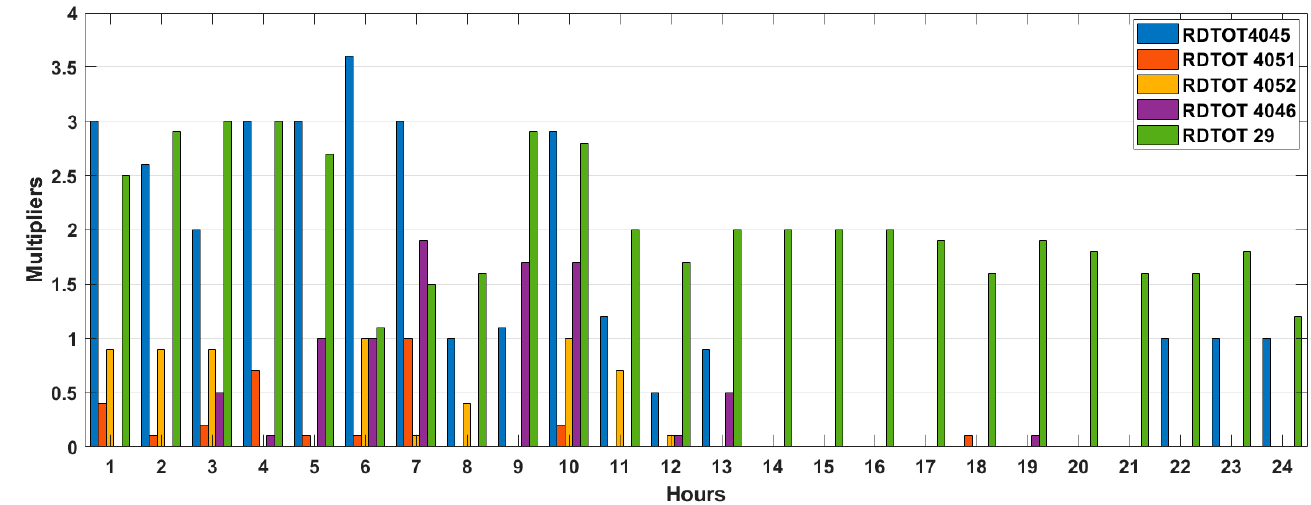
Figure 14. Chlorine injection dosage by pattern hour between the limits of 0.2 and 5 mg/L.